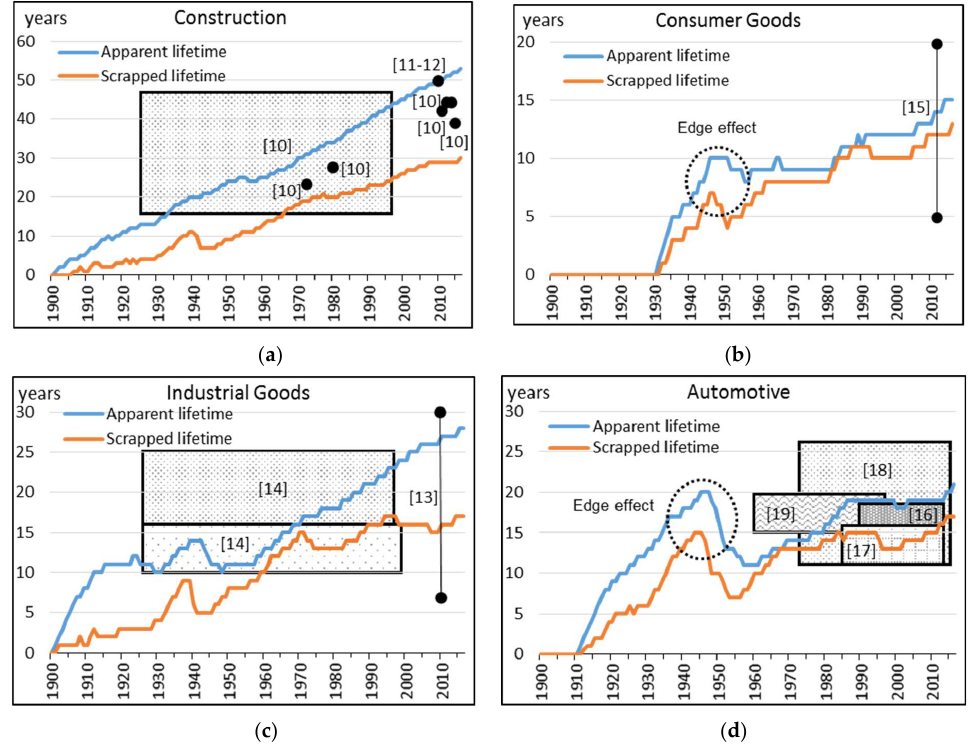
Figure 6. The scrapped and apparent lifetimes of steel in the U.S. between 1900 and 2016 calculated with the Volume Correlation Model (VCM), compared with previously reported lifetime measurements of steel products in-use in the U.S. (literature values are shown as filled circles for single years and boxes for studies referring to multiple years, with reference numbers indicated): ( a ) construction, ( b ) consumer goods, ( c ) industrial goods, and ( d ) automotive sector.